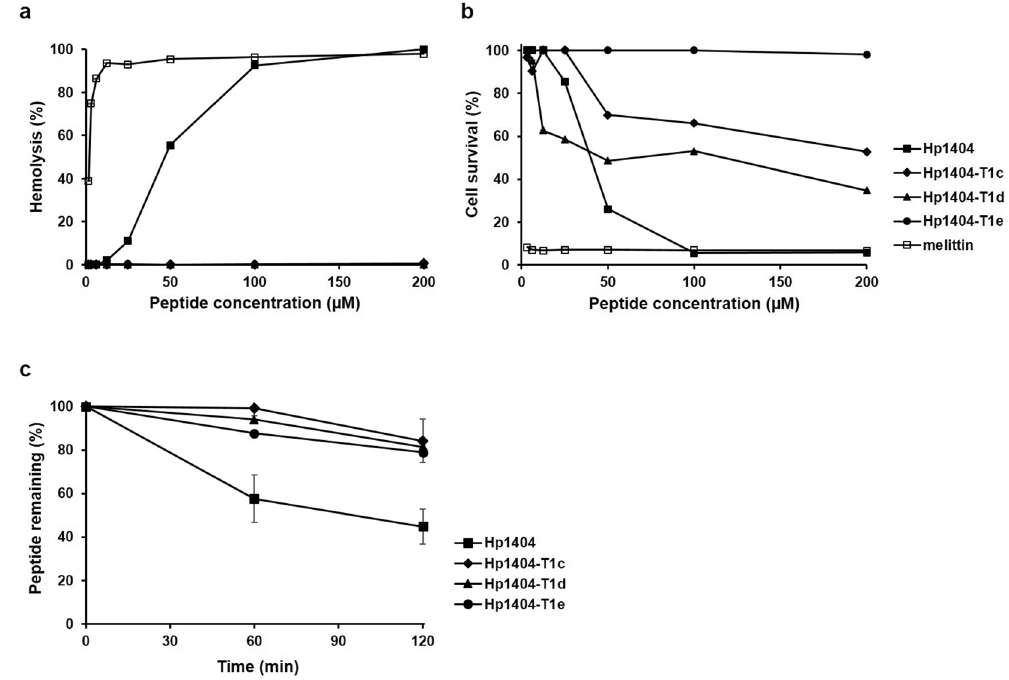
Figure 2. Toxicity and stability of synthetic peptides. ( a ) Hemolytic activity of peptides against mouse red blood cells. ( b ) Cytotoxicity of peptides was determined by examining their effect on the survival rate of HaCaT cells using the MTT assay. ( c ) Determination of the proteolytic stability of peptides plotted against time. Higher percentages indicate higher stability. The initial concentration for all four peptide samples was set to 100 µ g/mL. Each experiment was repeated three times.